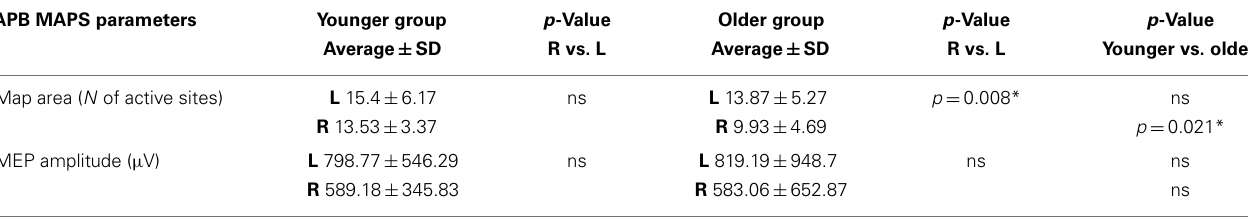
Table 2 | Maps parameters forAPB muscles are shown in both group of participants (younger and older) .